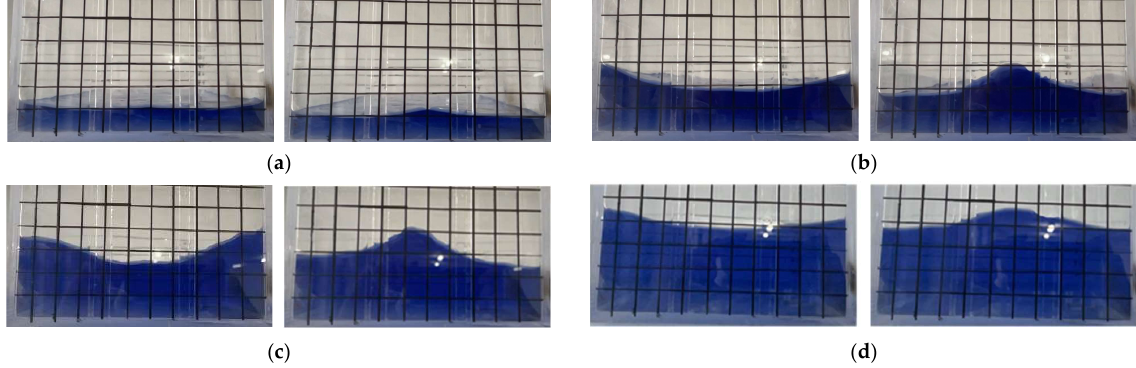
Figure 4. Water oscillation forms in resonance status of different water levels. ( a ) Water level of 2 cm. ( b ) Water level of 4 cm. ( c ) Water level of 6 cm. ( d ) Water level of 8 cm.